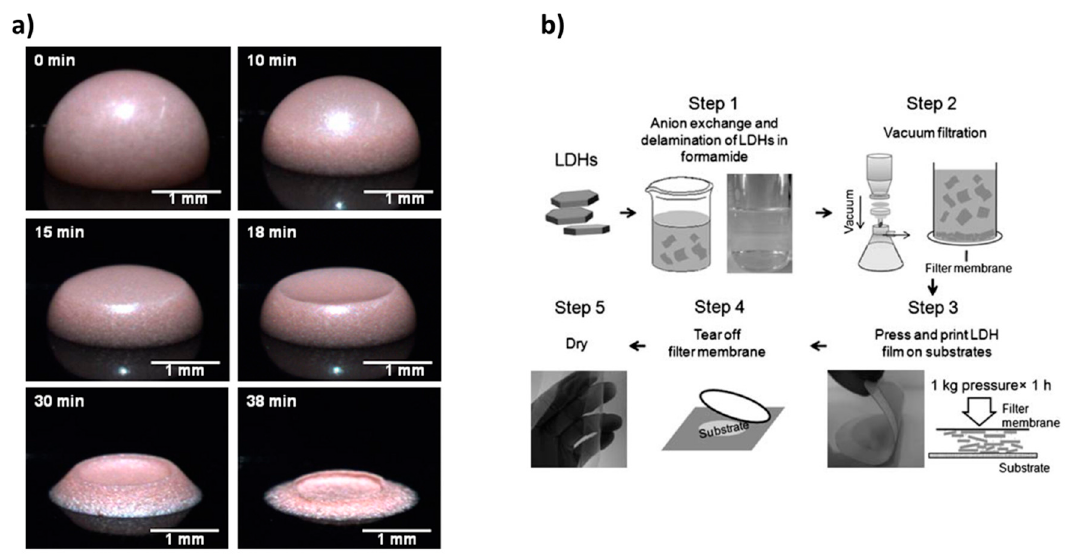
Figure 7. ( a ) Photographs of a drying drop of 2.0 vol% LDH dispersion at pH 3 as a function of drying time. Reprinted from Ref. [116]. Copyright (2013) with permission from Elsevier. ( b ) Schematic diagram of the preparation of LDH thin films and subsequent printing on substrates. Reproduced from Ref. [121] with permission from The Royal Society of Chemistry .